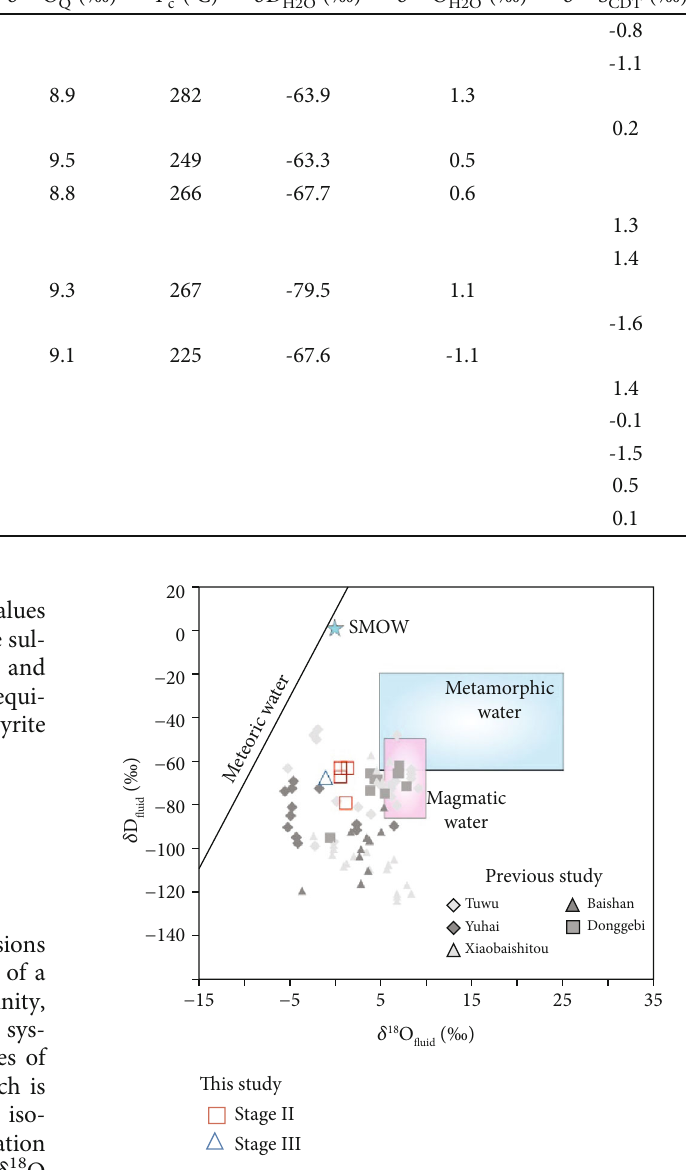
Table 3: Hydrogen, oxygen, and sulfur isotopic compositions of the Tieling Cu-Mo deposit. Sample no.